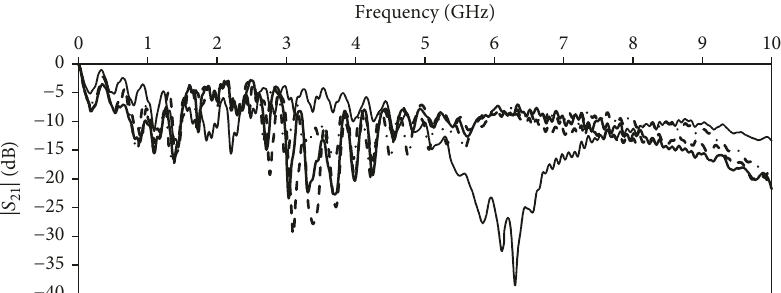
Figure 5: Measured frequency dependences | S